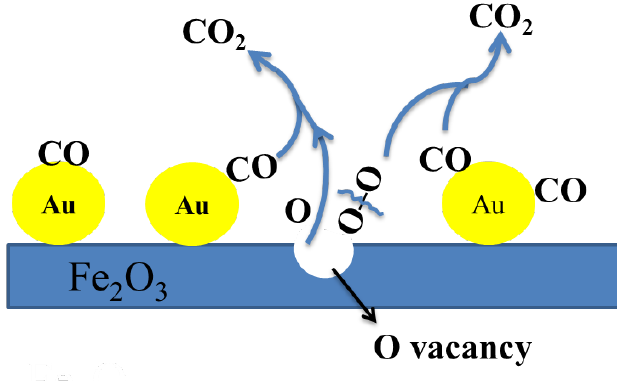
Figure 11. Schematic diagram of the possible CO oxidation mechanism for Au/α-Fe 2 O 3 .